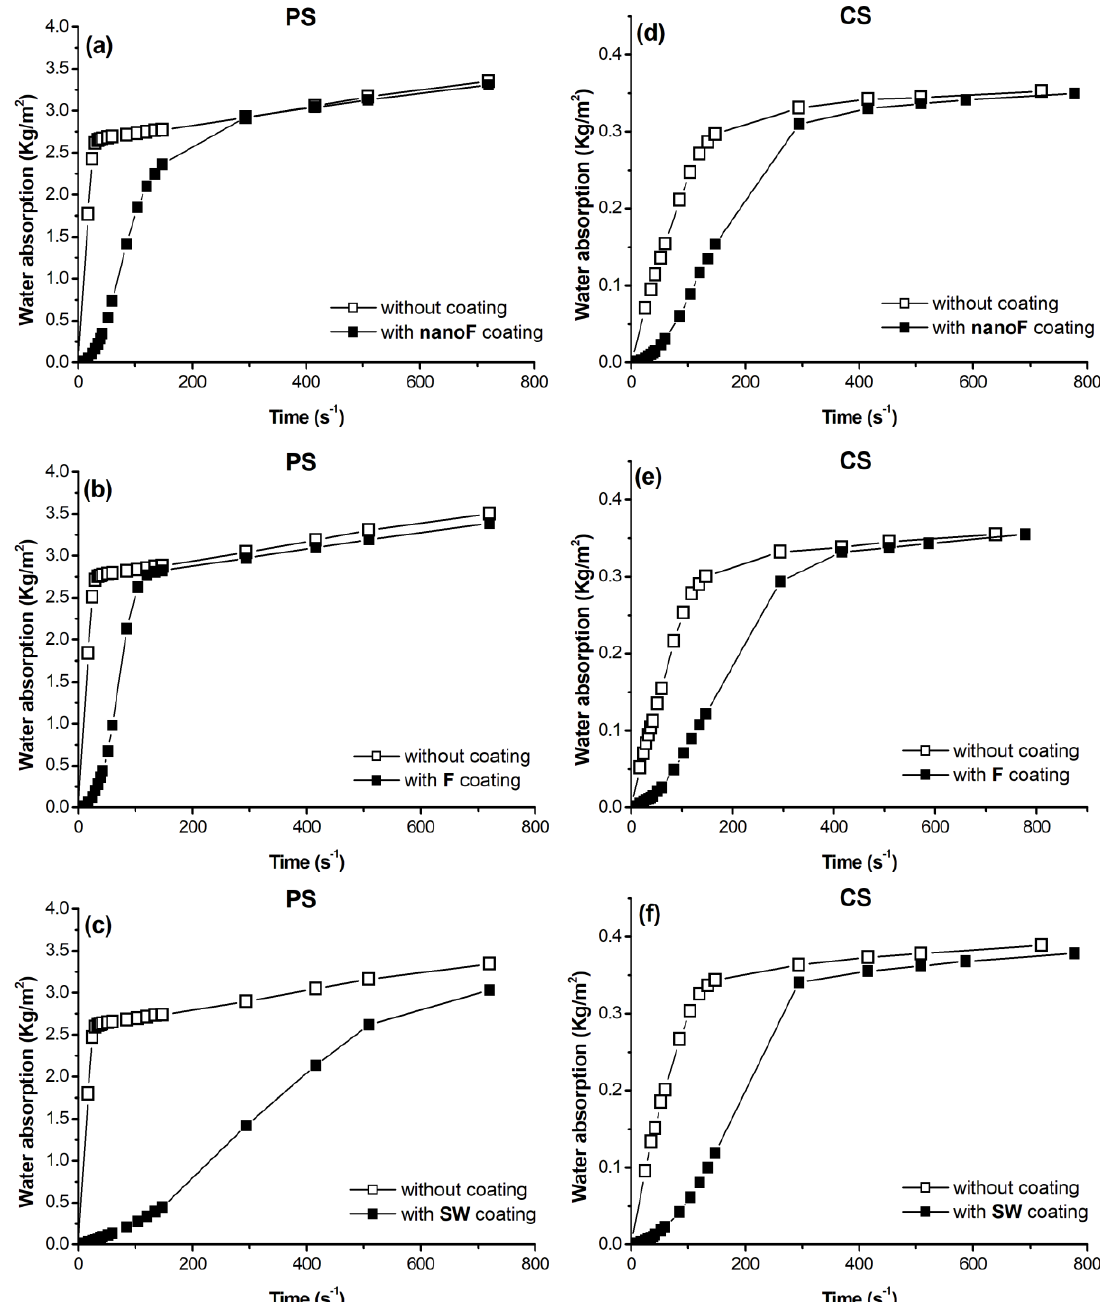
Figure 8. Capillary water absorption curves: ( a – c ) PS specimens with and without the nanoF, F and SW coatings, respectively; ( d – f ) CS specimens with and without the nanoF, F and SW coatings, respectively.